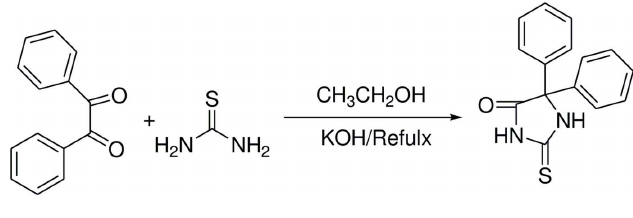
Figure 4 Synthesis of